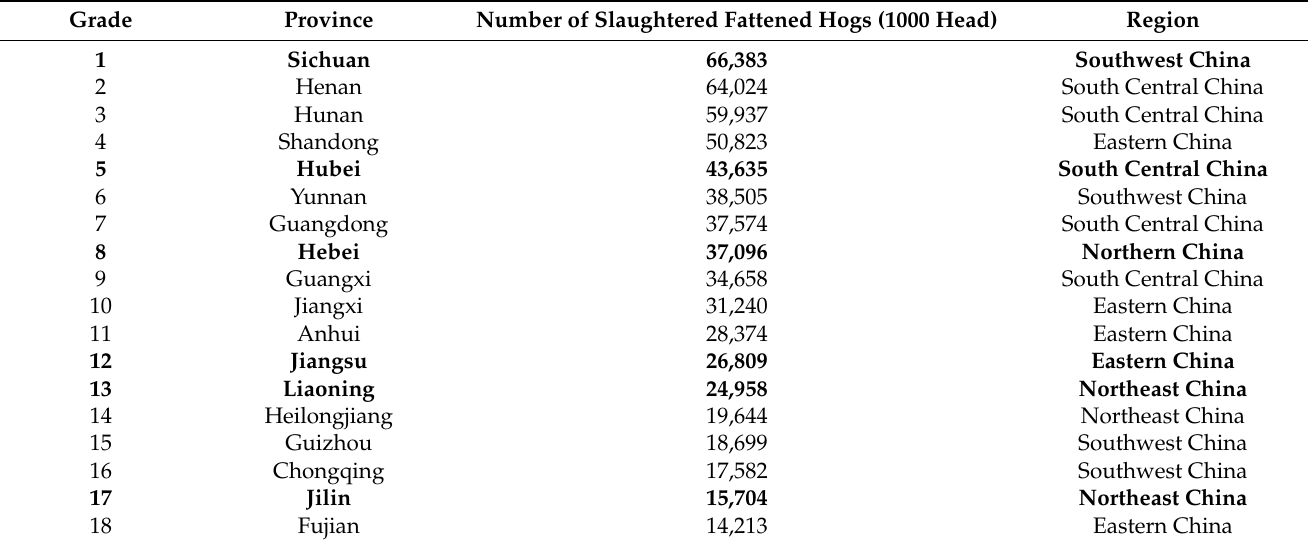
Table 1. Number of Slaughtered Fattened Hogs by Province in 2018.